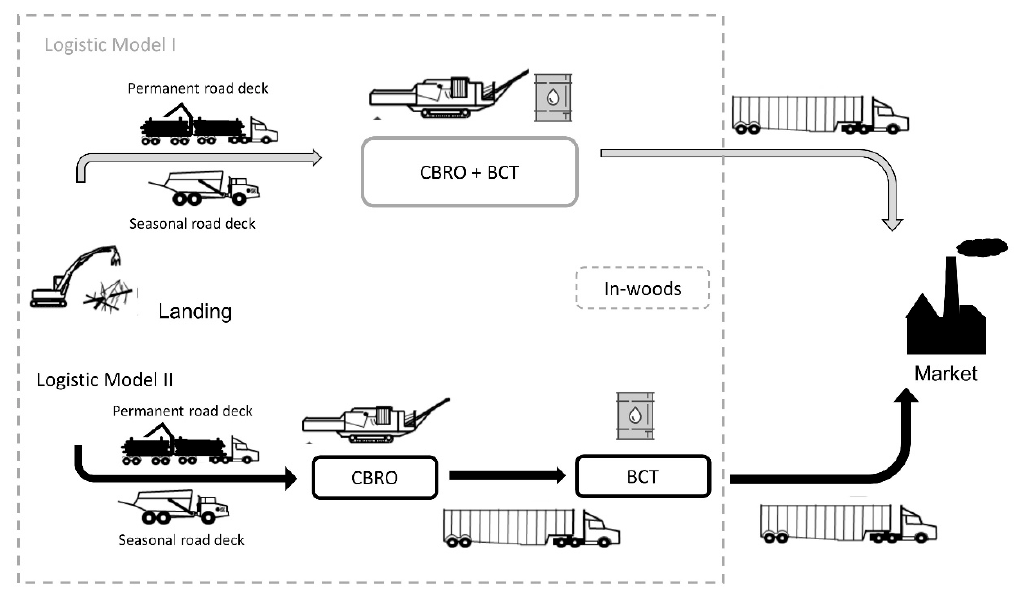
Figure 2. Graphical representation of the two logistics models (LM) I and II. Table 1. Spatial requirements (in hectare) associated with each logistics model (LM) and associated scenarios adopted from Biomass Research Development Initiative final report [38]. CBRO and BCT denotes centralized biomass recovery operation and biomass conversion technology, respectively. Without Storage 1 With Storage CBRO Sites BCT